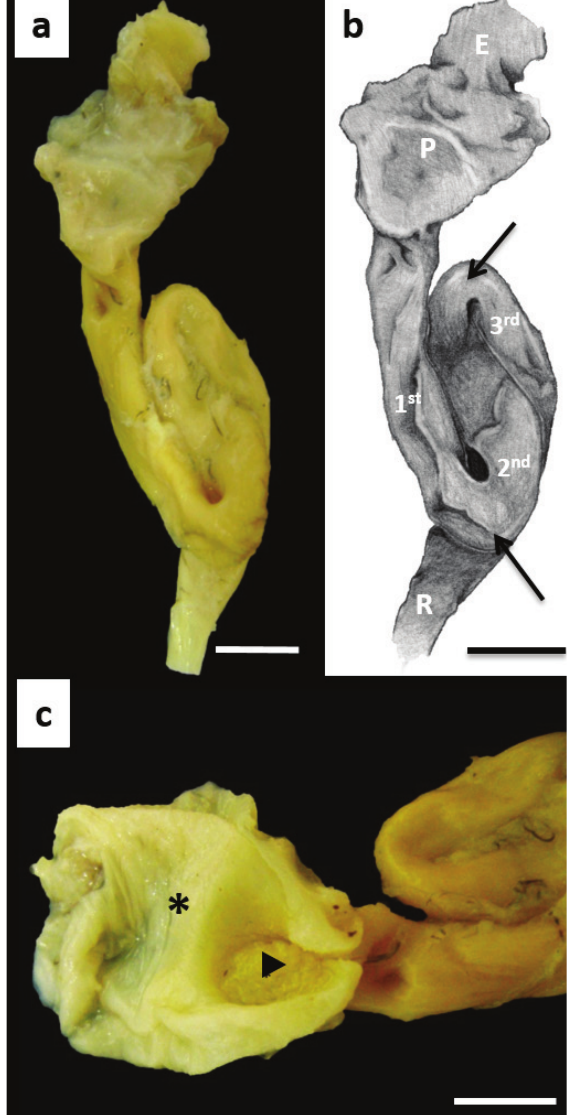
Figure 2 - Composition of the digestive tract of Sphoeroides testudineus. – a and b. Scheme of the digestive tract showing the esophagus (E), abdominal pouch (P), intestinal segments (1 st , 2 nd and 3 rd ) evidencing the intestinal loop (arrows), rectum (R). – c. Inside view of the abdominal pouch showing the esophageal sphincter (arrowhead) and the mucosa of the pouch (asterisk). Bar: 1.0